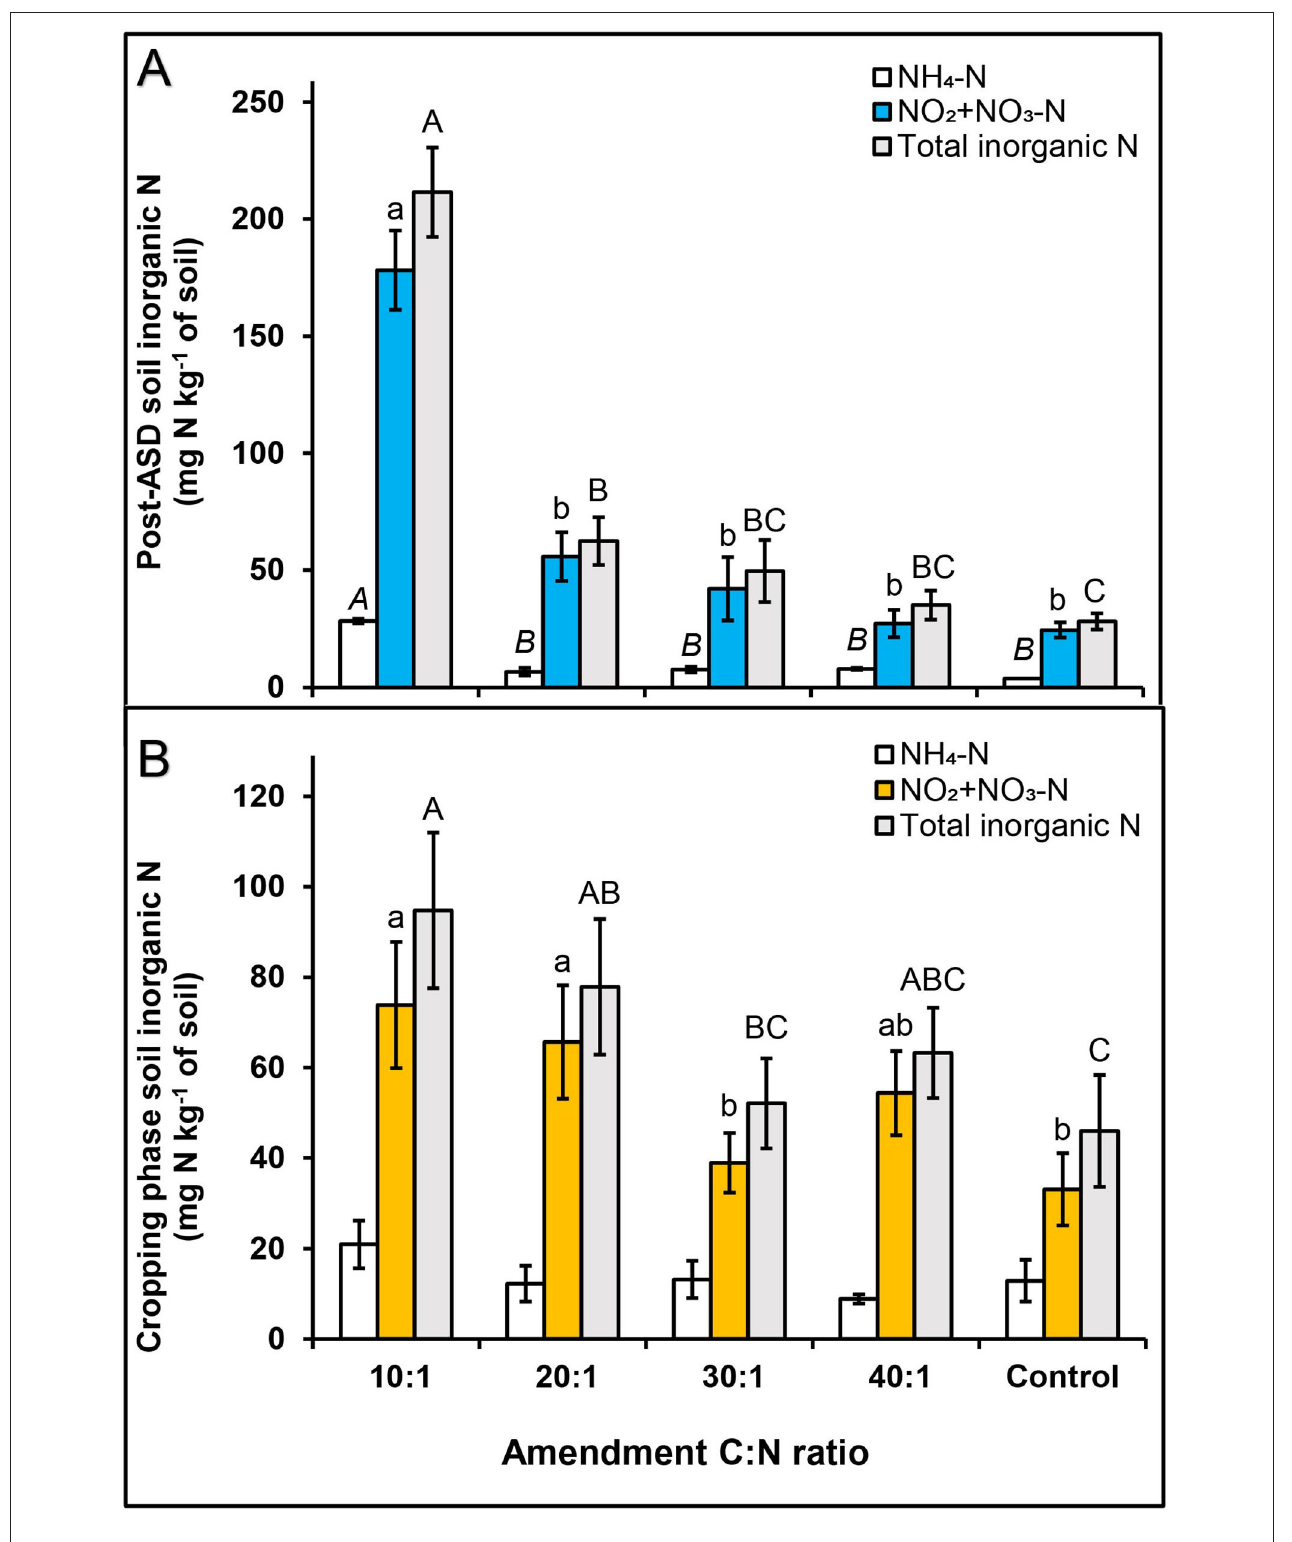
FIGURE 2 | Effect of ASD amendment C:N ratio across amendment types (dry molasses/soybean hull-based and wheat bran-based) on soil inorganic N at (A) post-ASD treatment and (B) during cropping phase, trial 1. Bars indicated by similar letters for each category are not significantly different at P < 0.05 according to Fisher’s protected LSD test. Error bars indicate standard error with eight total replicates (4 replicates × 2 experiments). Control = anaerobic, non-amended control.